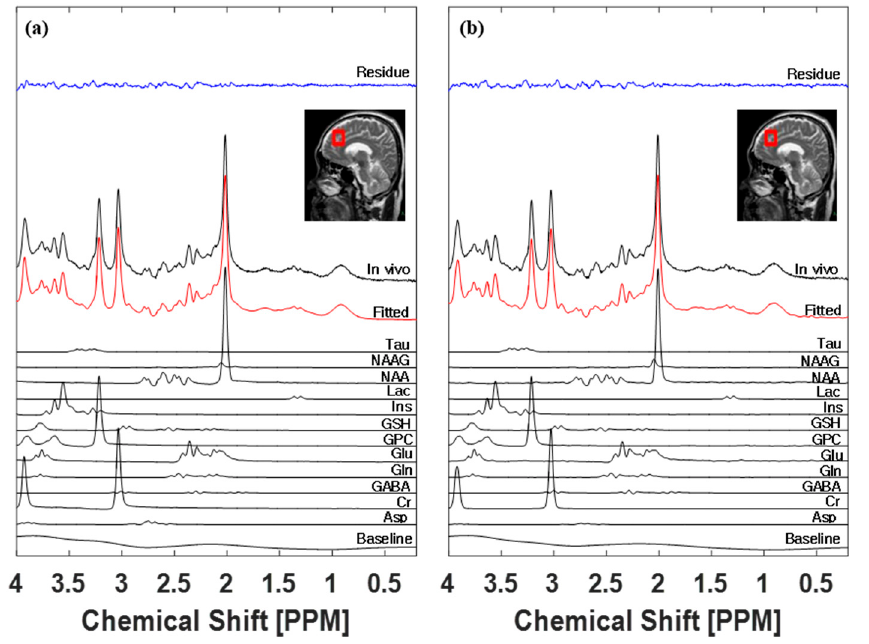
Figure 3. LCModel spectral fitting results with ( a ) and without ( b ) in-house basis sets. Fitting residue, VOI with sagittal T2 image, in vivo, fitted, individual spectra, and baseline are represented with names. Table 1. CRLBs of metabolites and macromolecules and comparison of group difference by paired t -test.